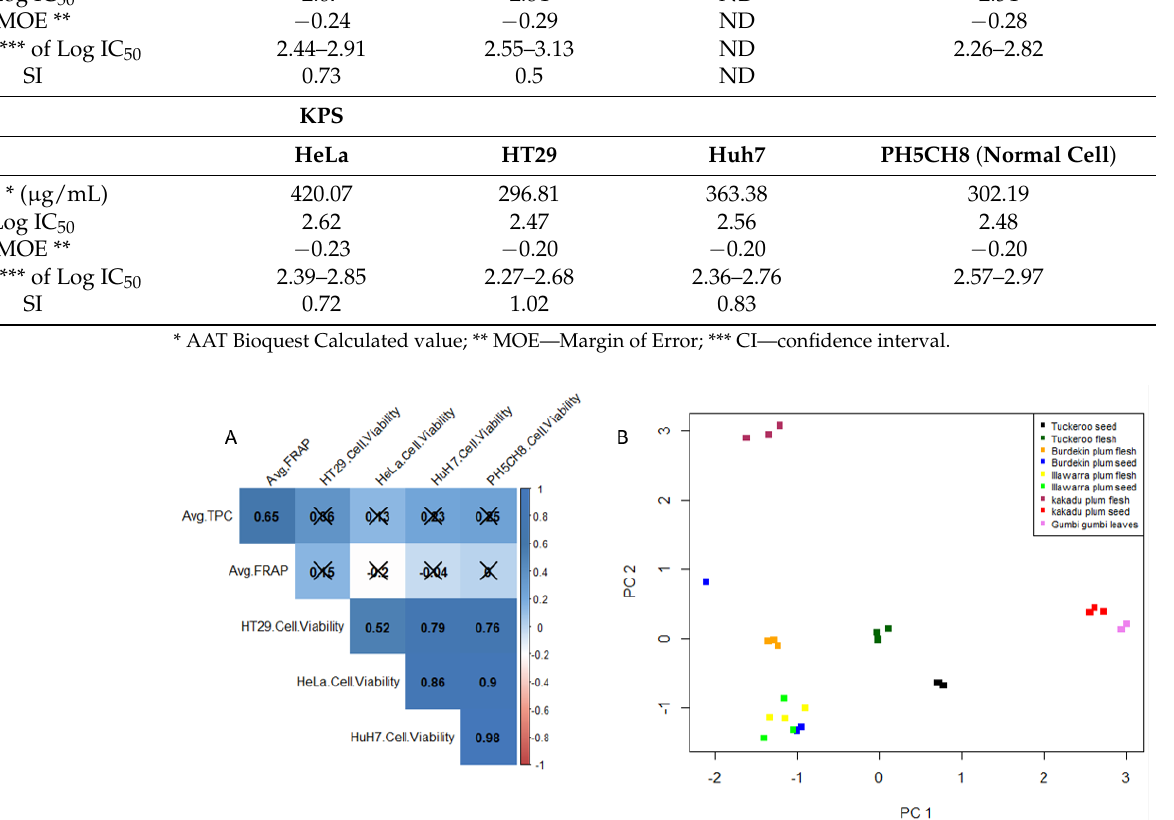
Figure 4. ( A ) Correlation plot; ( B ) PCA scores plot.